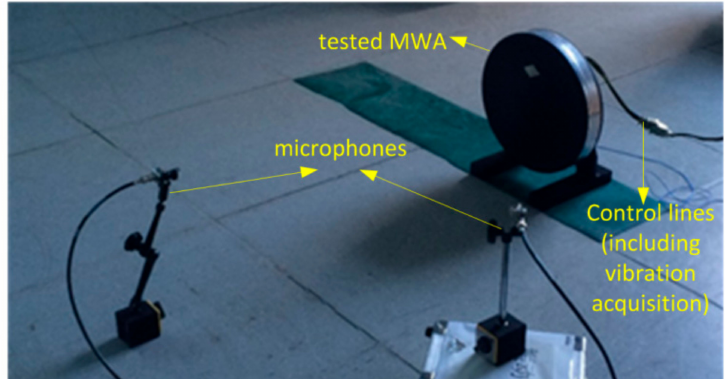
Figure 7. Acoustic and vibrational experiments of an